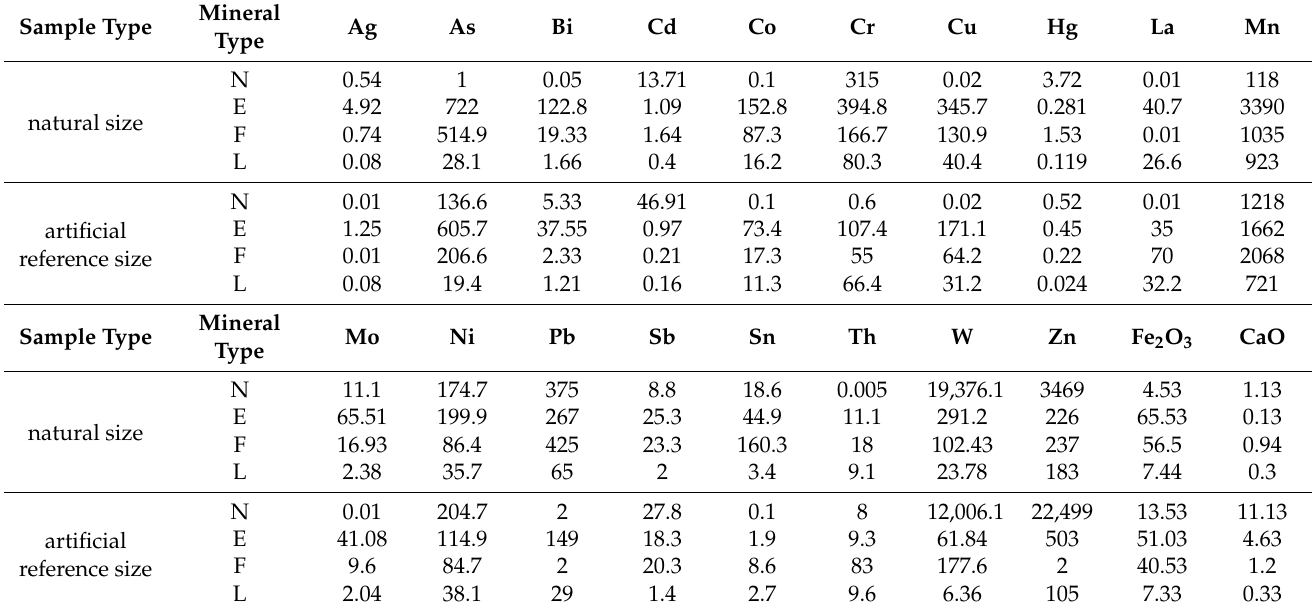
Table 2. Element concentrations in minerals in 0.84–0.42 mm fraction of stream sediments.